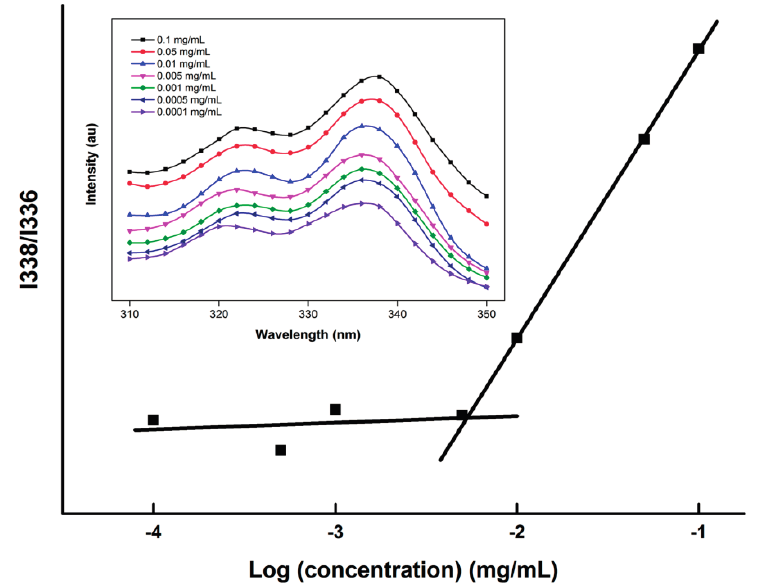
Figure 3. The representative plots of I338/I336 versus log C of PEG-p(Glu) The excitation spectra of polymer solution with different concentrations in the presence of pyrene are shown in the